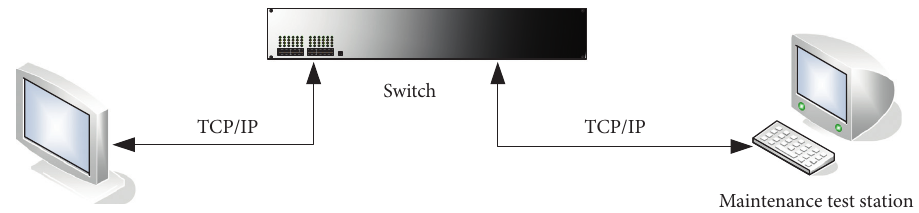
Figure 10: Schematic diagram of connection between SVDU simulator and maintenance test station.